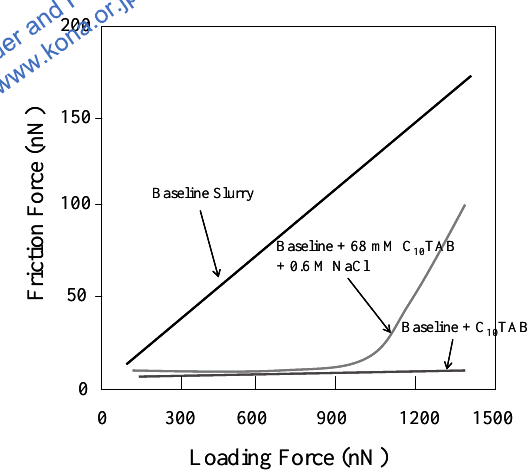
Fig.3 AFM friction force measurements on silica wafer for silica slurry containing C 10 TAB and NaCl as additives ( Fig.9 from [8)]; Re- drawn with permission from